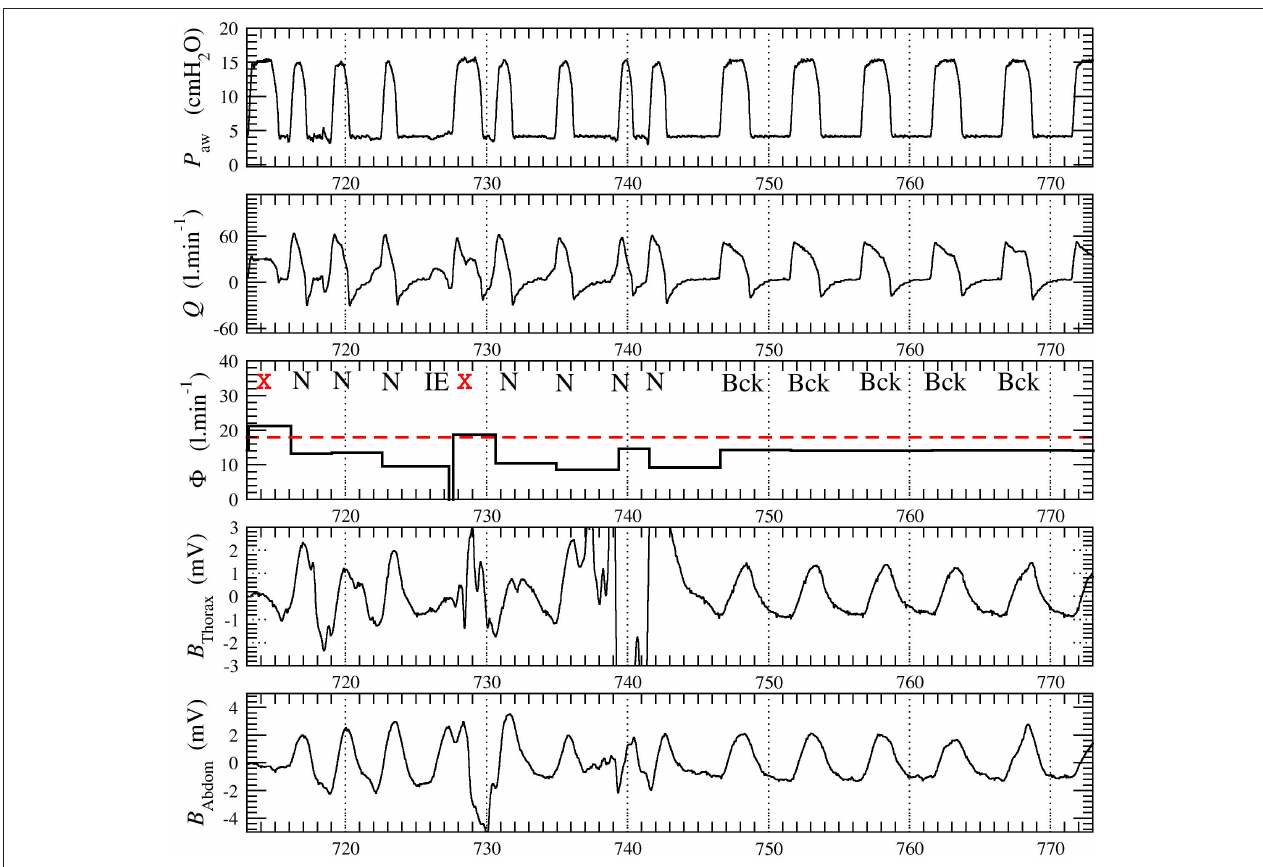
FIGURE 1 | Excerpt from the 20-min times series recorded in patient 1. The leakage 8 is averaged over each ventilatory cycle. The belt signals B thorax and B abdom were provided to the physicians for reviewing the automatic scoring. The ventilatory cycles at t = 713 s and t = 728 s (marked with red cross) were automatically discarded by SyncSmart due to its excessively turbulent aspect and because the leakage 8 exceeds the threshold 8 t , here equal to 18 l min − 1